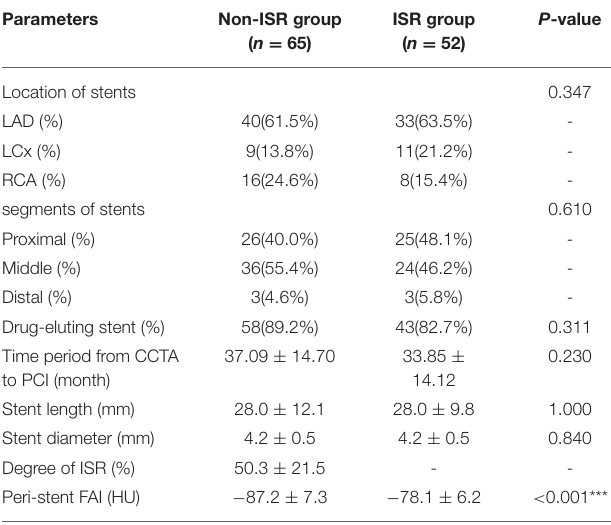
TABLE 3 | Stent characteristics and peri-stent PVAT performance between the two groups.